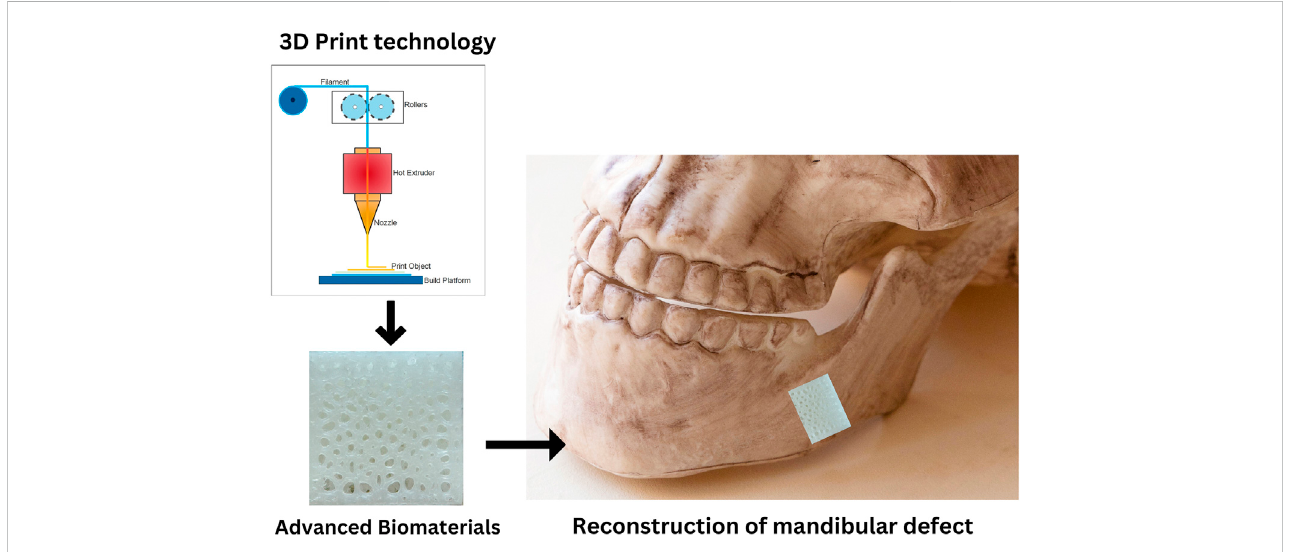
FIGURE 1 Biomaterial schematic for mandibular defect reconstruction. Adapted from Zhang et al.